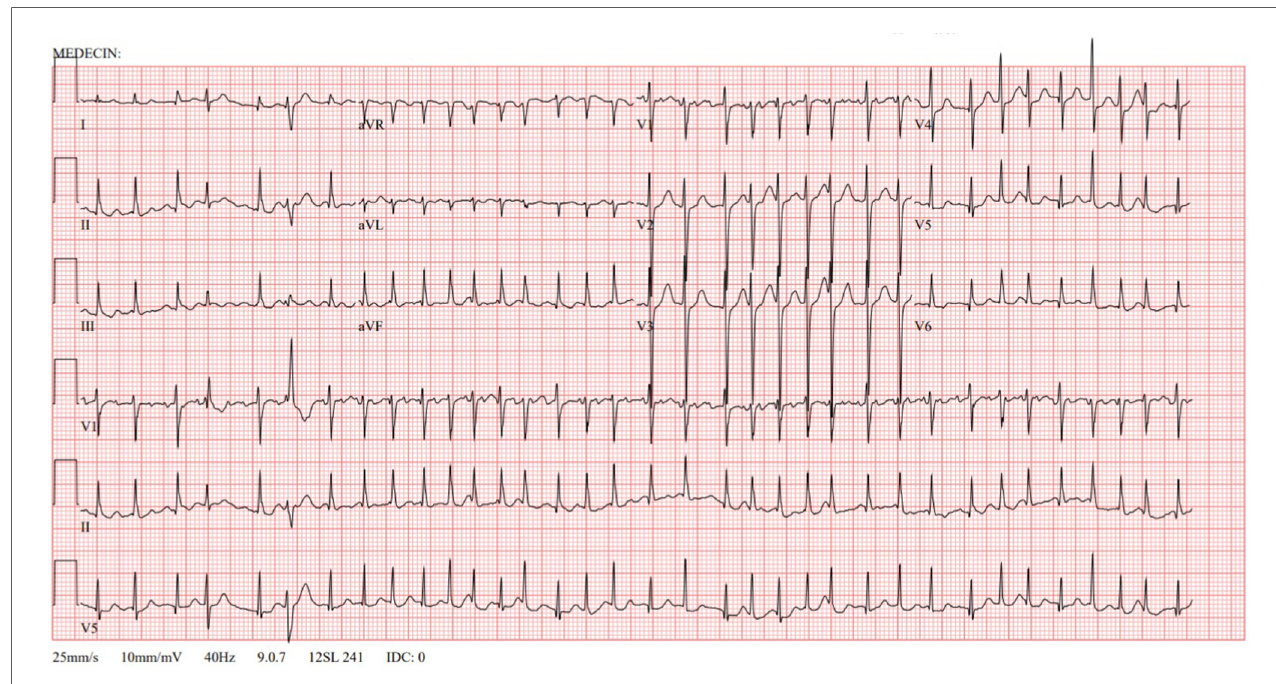
FIGURE 1 Electrocardiogram at onset. Atrial fi brillation with a rapid ventricular response. Incomplete right bundle branch block secondary to fast heart